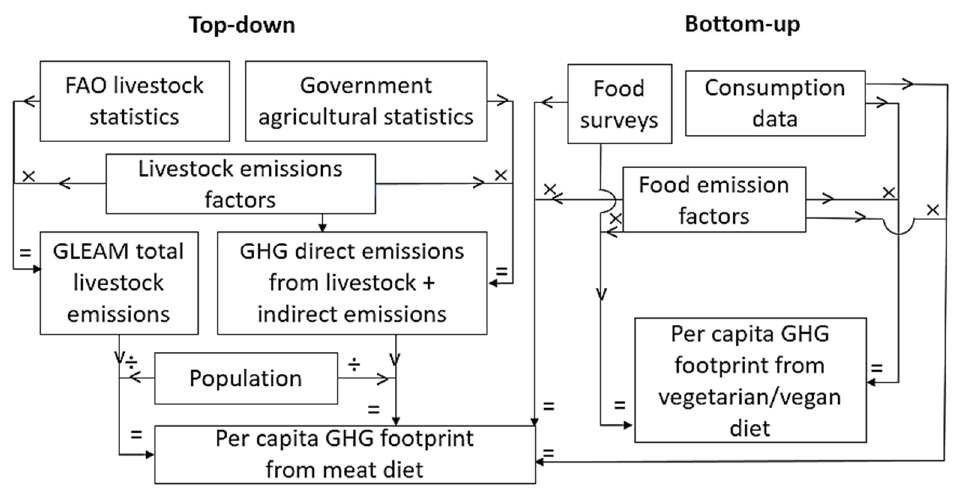
Figure 2. Structure of the current study using top-down and bottom-up methods to determine the contribution of meat consumption to GHG footprints.